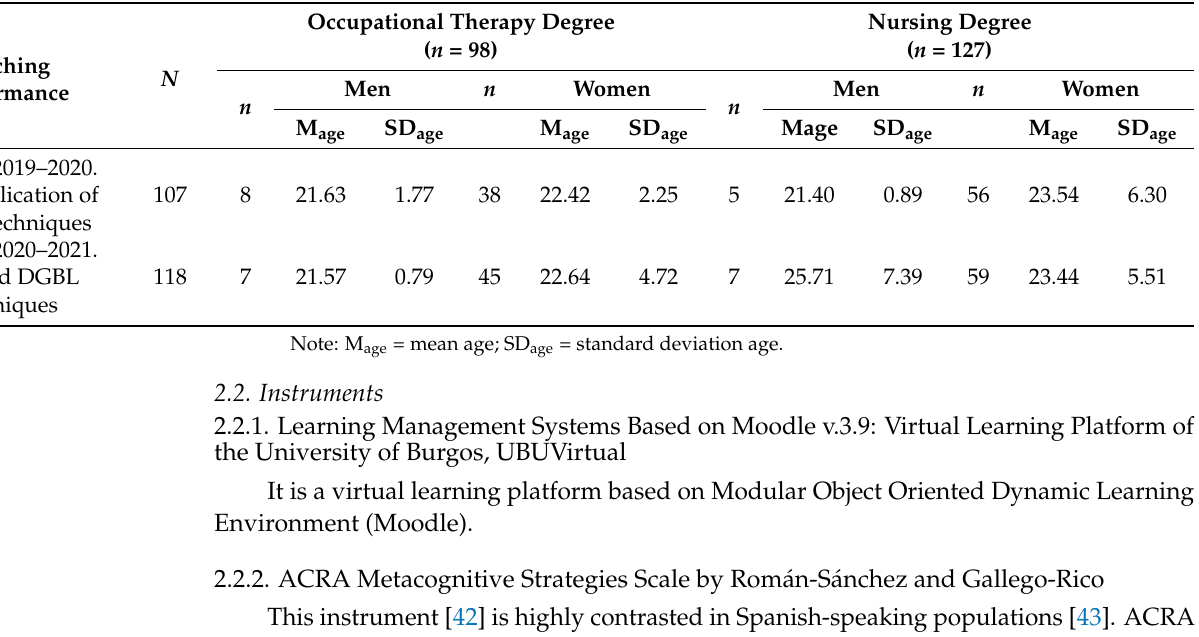
Table 1. Descriptive statistics in the sample of